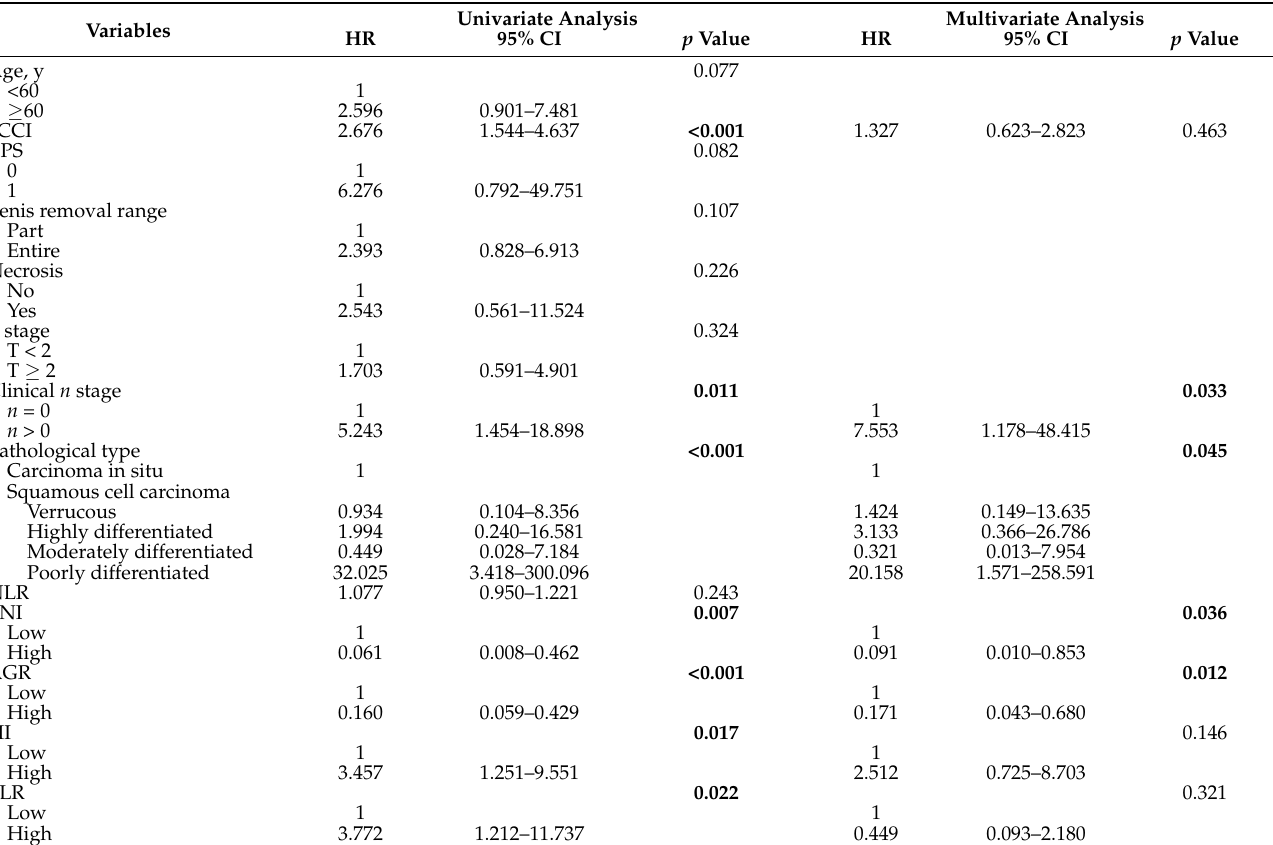
Table 3. Univariate and multivariate analysis of